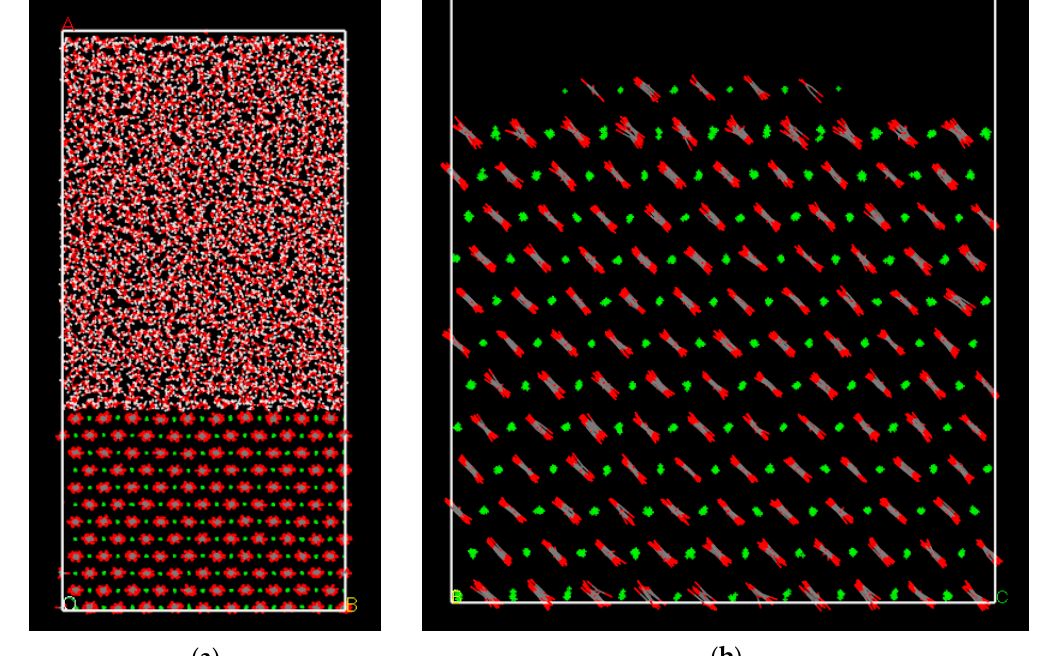
(cid:8) (cid:9) 1014 slab in the bottom,